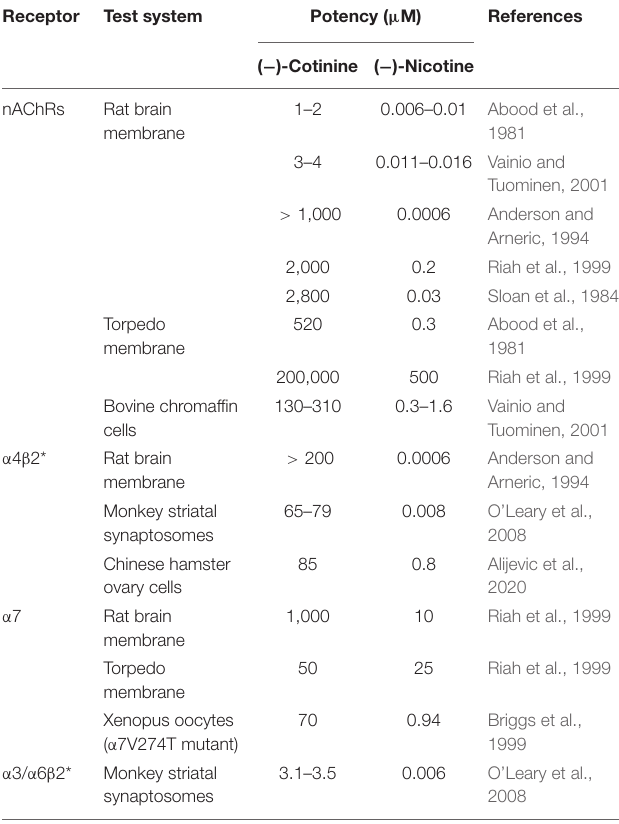
TABLE 1 | Summary of receptor binding and agonistic potency of cotinine for nAChRs and specific subtypes. Receptor Test system Potency ( µ